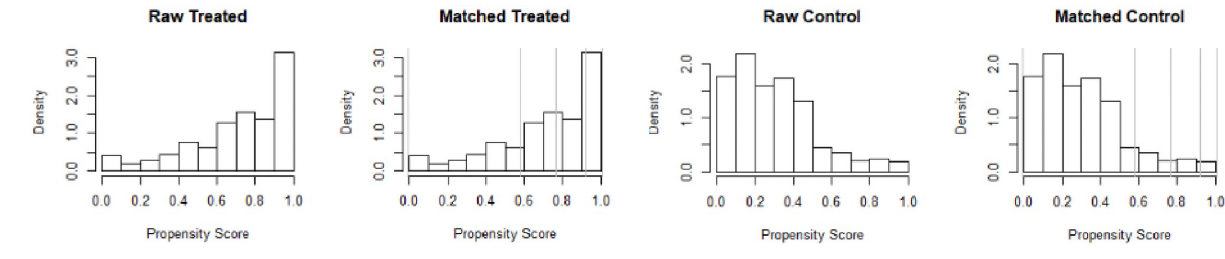
Fig 3. #check matched treated vs matched